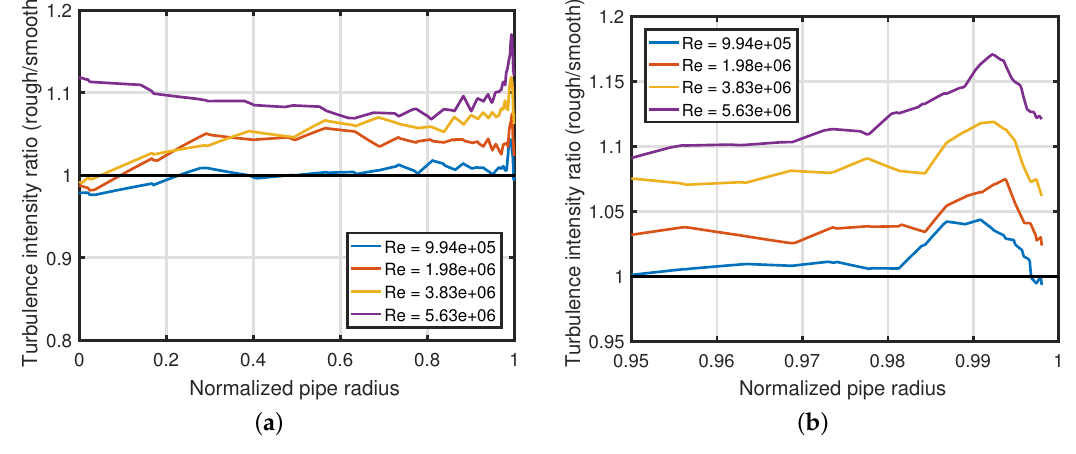
Figure 3. Turbulence intensity ratio (TIR); ( a ): all radii; ( b ): zoom to outer 5%. Information on fits of the TI profiles to analytical expressions can be found in Appendix